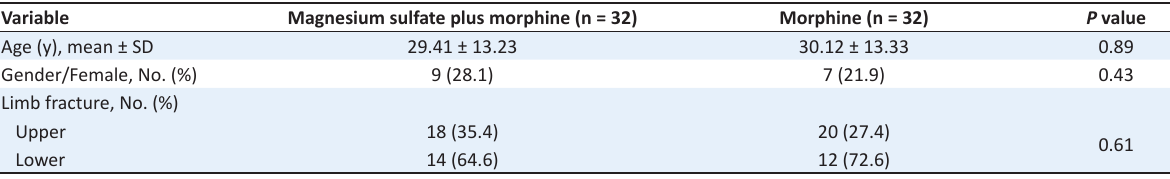
Table 1. Patient’s